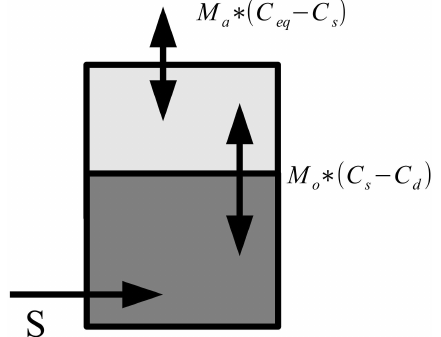
Figure 3. Two box schematic of a tracer with a source (or sink) in the deep ocean, the signal of which is transported to the surface box by mass transport M o and equilibrated with the atmosphere by mass transport M a